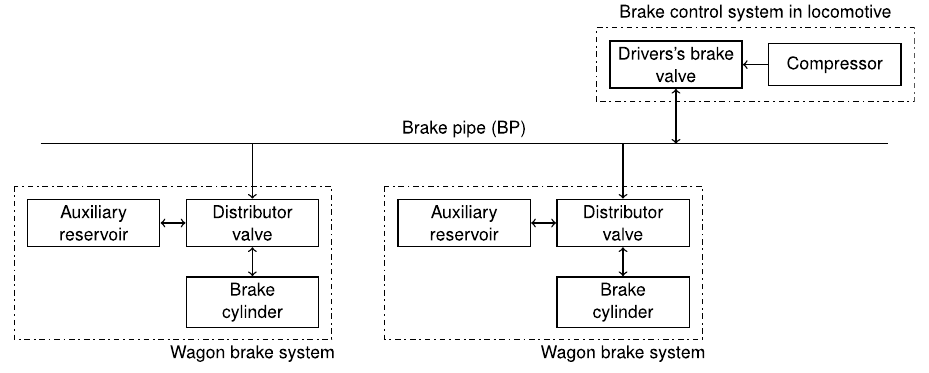
Fig. 2 Train-wide brake system schematic (only two